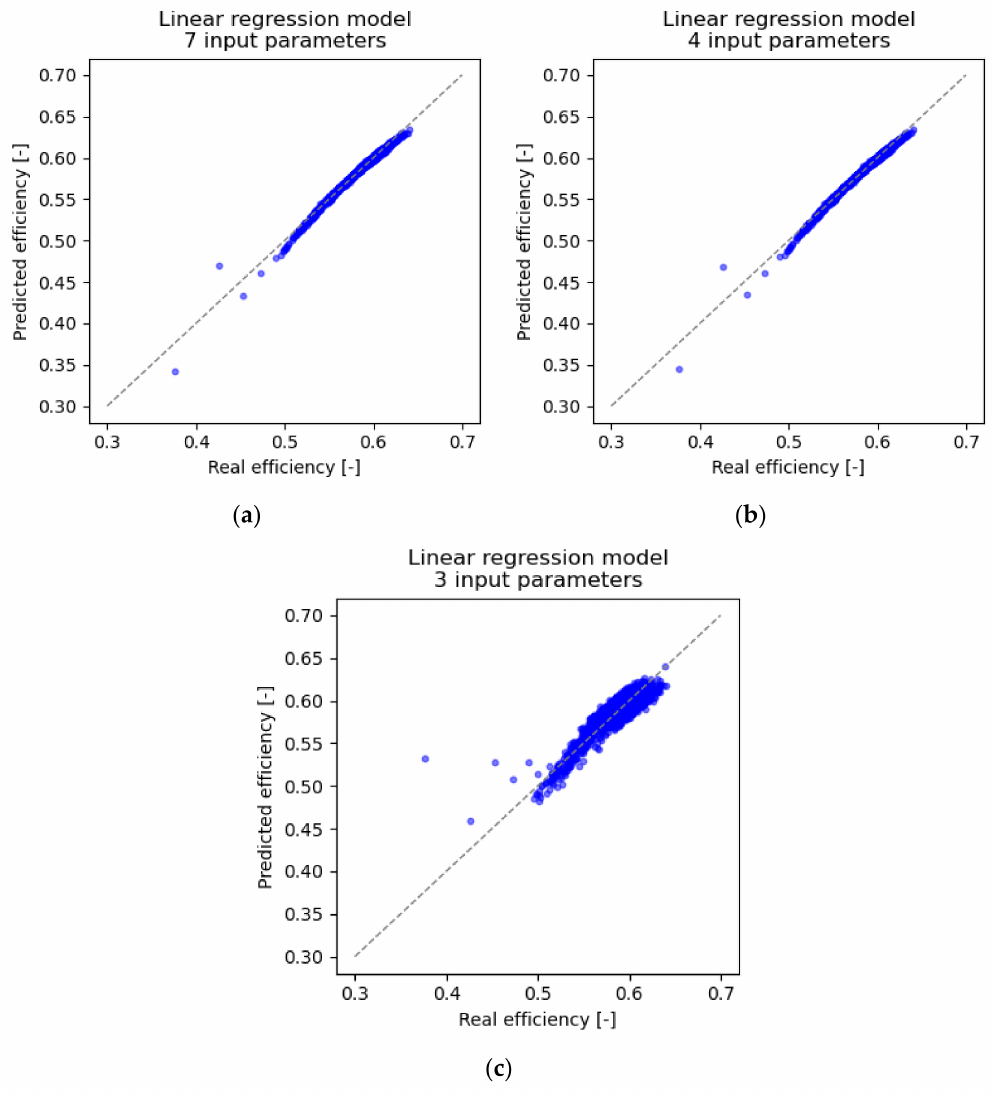
Figure 7. Predicted values as a function of actual values for 3 linear regression models with a decreasing number of input parameters; ( a ) 7 inputs parameters, ( b ) 4 inputs parameters, ( c ) 3 in- puts parameters.